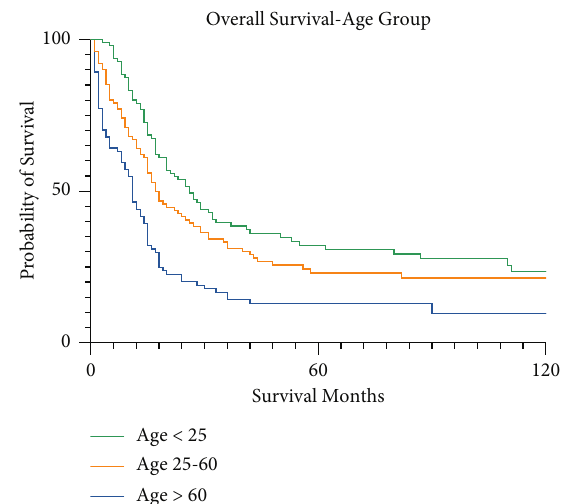
Figure 4: Kaplan–Meier survival curves for pelvic osteosarcoma patients by age